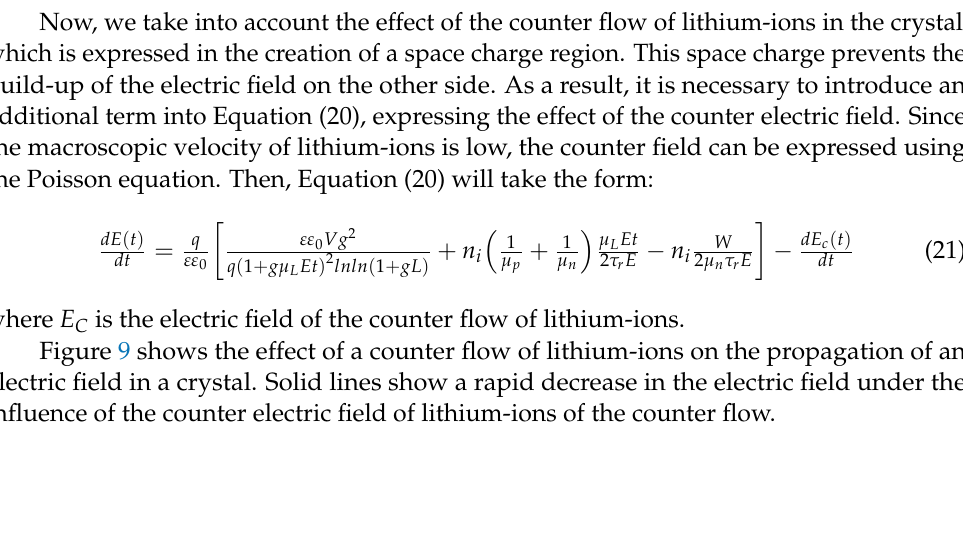
Figure 8. The flux density of lithium-ions in a crystal during the double-sided drift process, taking into account the presence of uncompensated lithium-ions.